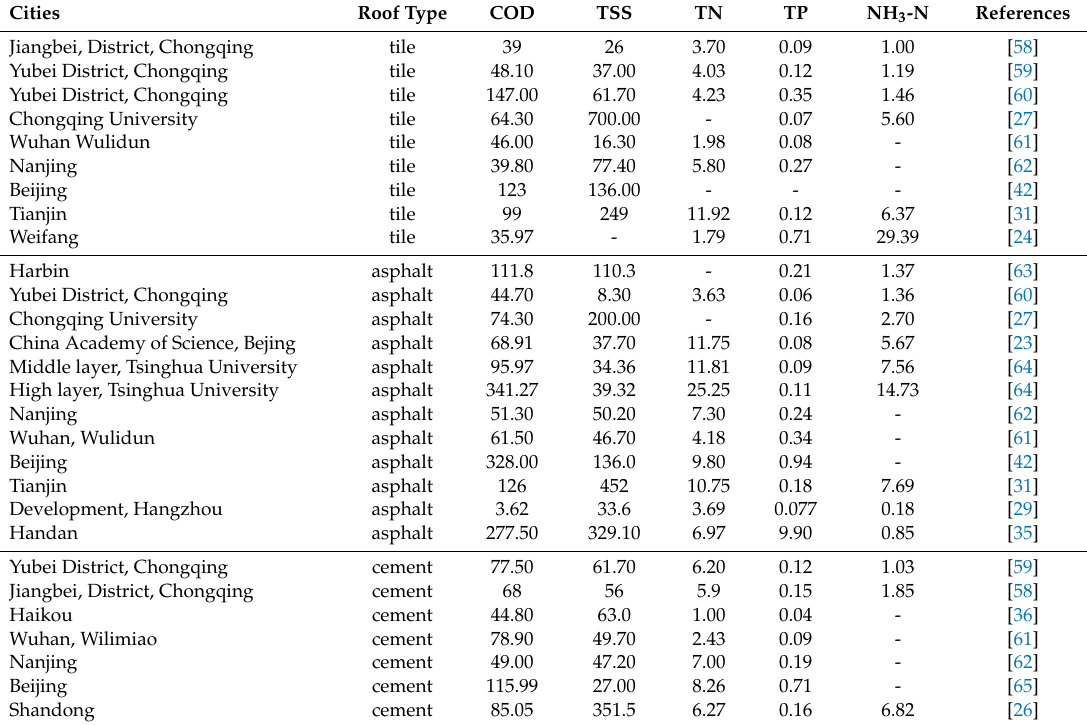
Table 3. The concentration of roof runo ff pollutants (mg L − 1 ).